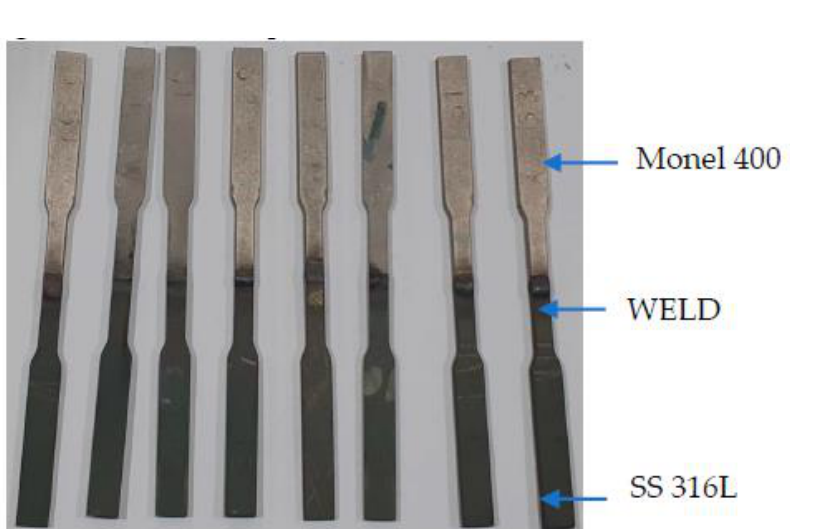
Figure 2. Tensile test specimens